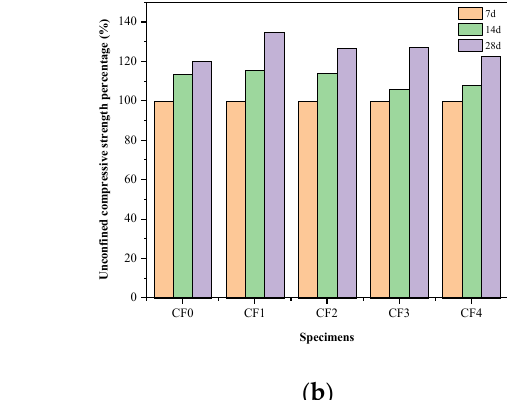
( b ) Figure 3. ( a ) ITS of CSM with 100% RMA under different fly ash replacement rates and ( b ) The ratio of ITS at different ages to the 7 d strength.